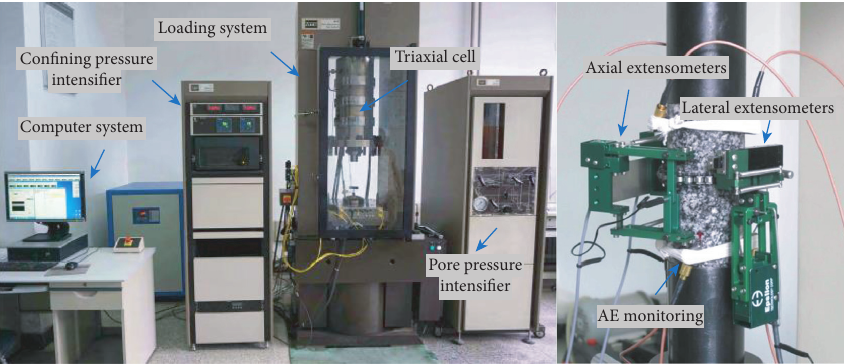
Figure 4: MTS 815 rock mechanics apparatus. Table 1: The key parameters of AE instrument related to the measurement.